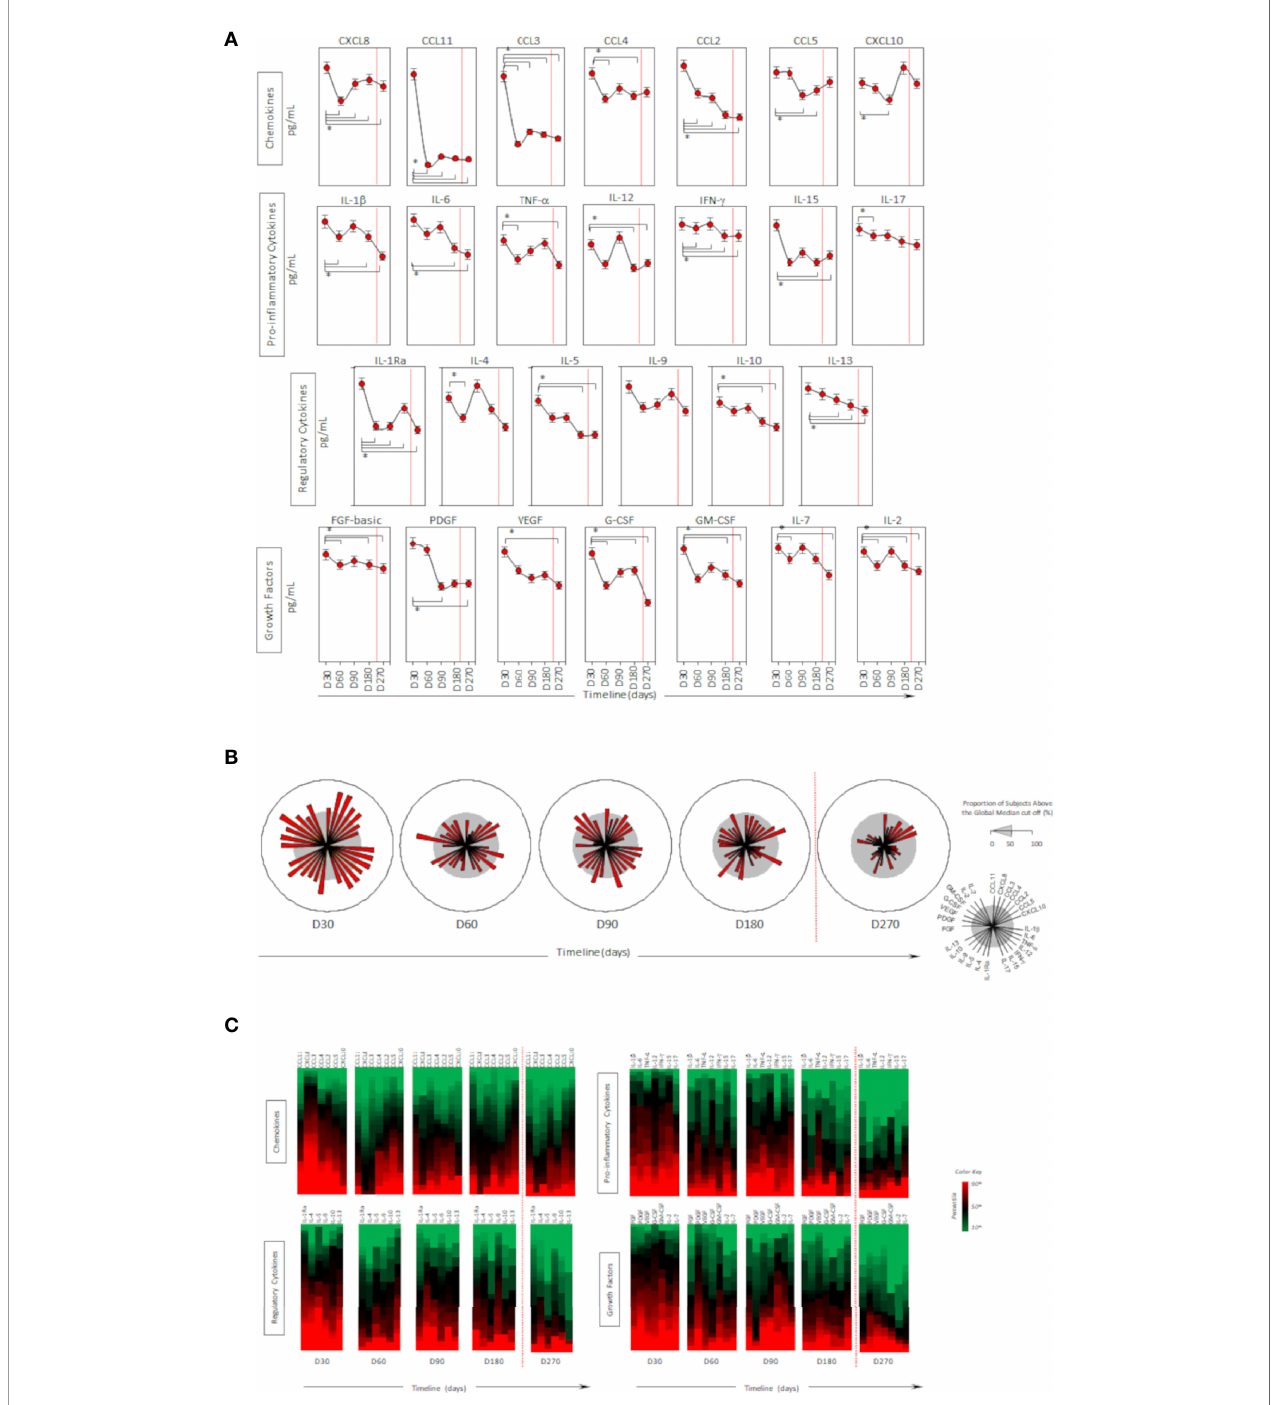
FIGURE 4 | Timeline kinetics of serum biomarkers in participants vaccinated with CoronaVac two-dose regimen plus BNT162b2 booster dose. Cross-sectional follow-up analysis of levels of chemokines (CXCL8, CCL11, CCL3, CCL4, CCL2, CCL5, CXCL10); pro-in fl ammatory cytokines (IL-1 b , IL-6, TNF- a , IL-12, IFN- g , IL-15, IL-17); regulatory cytokines (IL-1Ra, IL-4, IL-5, IL-9, IL-10, IL-13) and growth factors (FGF-basic, PDGF, VEGF, G-CSF, GM-CSF, IL-7, IL-2) was carried out in serum samples. Measurements were performed at distinct times post second dose protocol (30-, 60-, 90-, 180-, and 270-days). Biomarkers were presented individually in multiple subpanels and displayed in classes: chemokines, pro-in fl ammatory cytokines, regulatory cytokines, and growth factors. Red dotted lines represent the booster dose timepoint. In (A) timeline kinetics; (B) overall signature of mediators; and (C) heatmap constructs. ANOVA statistical differences are presented by the letter for comparisons over timepoints